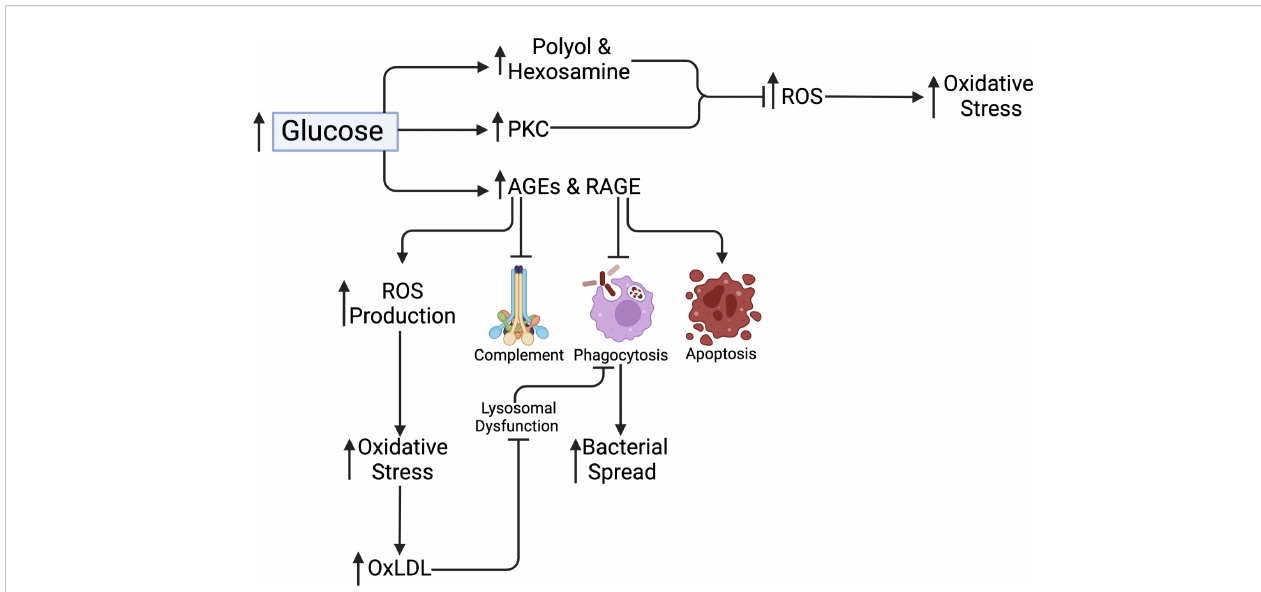
FIGURE 4 Metabolic pathways related to hyperglycemia. Polyol and Hexosamine and PKC pathways cause increased ROS production and uptake resulting in increased mitochondrial stress. AGEs and RAGE production inhibits complement activation and macrophage phagocytosis, as well as promote macrophage apoptosis and increased ROS production. This increases oxidative stress, resulting in increased OxLDL. OxLDL causes lysosomal dysfunction and phagocytosis, which promote bacterial